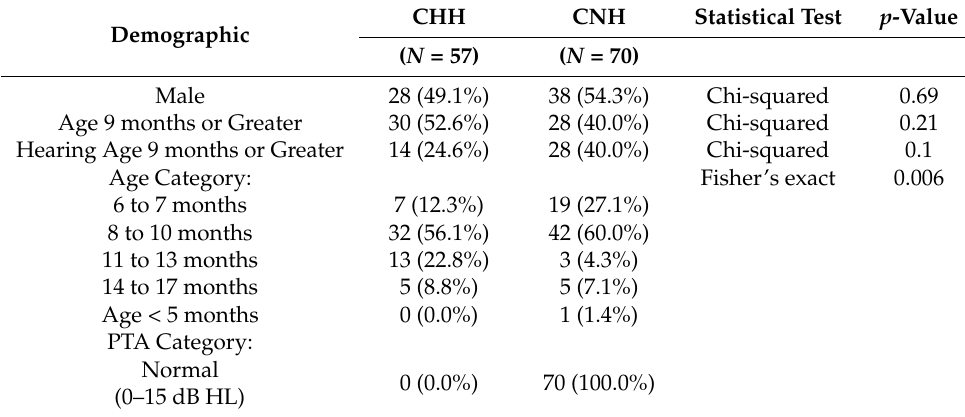
Table 1. Participant Characteristics with results presented as mean (standard deviation) for continu- ous measures and frequency (percent) for categorical